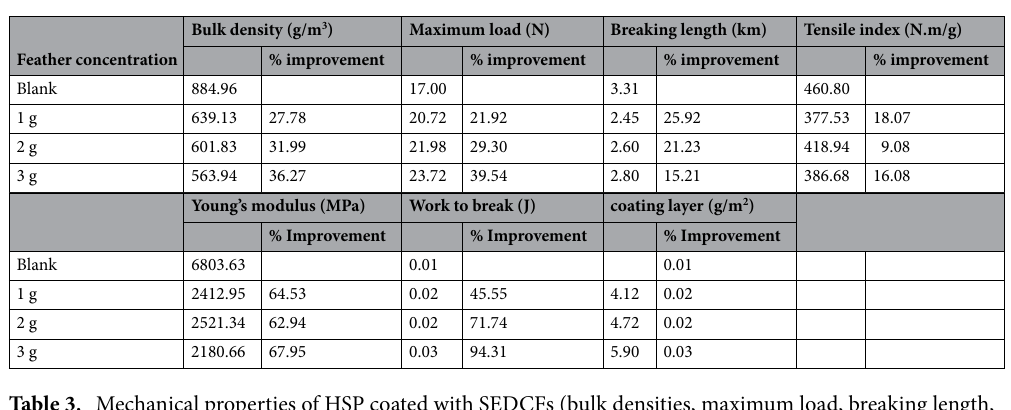
Table 3. Mechanical properties of HSP coated with SEDCFs (bulk densities, maximum load, breaking length, tensile index, Young’s modulus, work to break and coating layer).